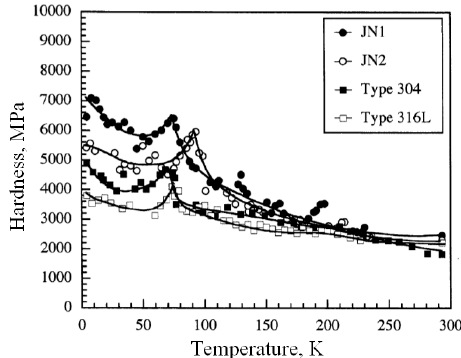
Figure 16. Temperature dependence of hardness for austenitic stainless steels [63].